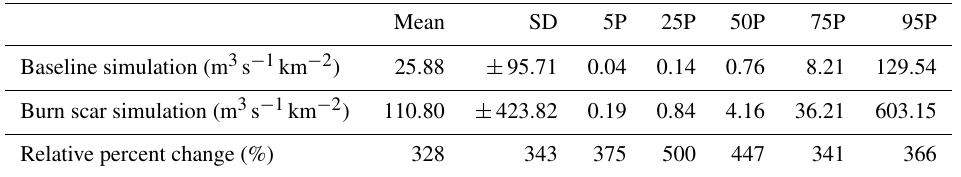
Table 3. Statistics, including the mean, standard deviation (SD), 5P, 25P, 50P, 75P, and 95P, of the catchment-area-normalized peak discharge for all the 404 basins within the Dolan burn scar in the baseline and burn scar simulation and their relative percent changes. We conduct similar analyses using accumulated discharge volume in Table B5 in Appendix